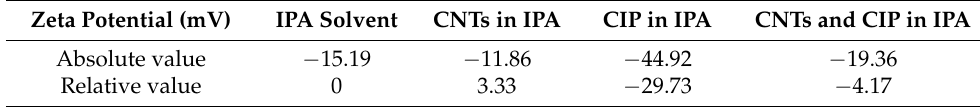
Table 2. Zeta potential test results of the CNTs and CIP in IPA